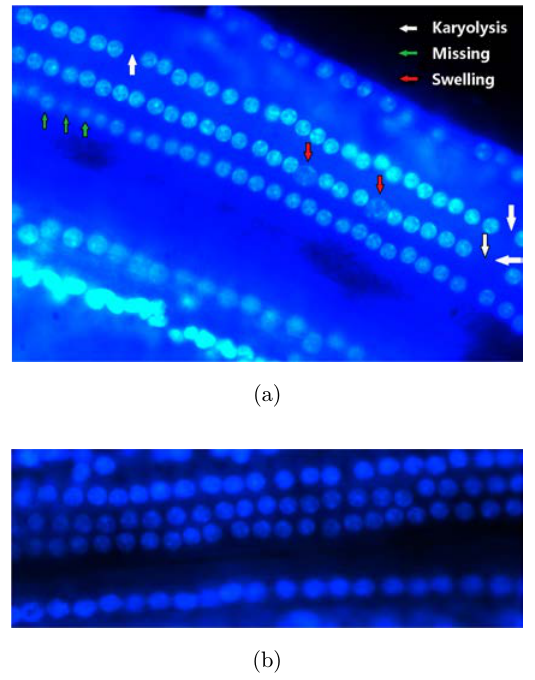
Fig. 4. The cochlear stretched preparations observed under a °uorescence microscope. The three bright bead chains in the upper left corner are the outer hair cells. (a) A cochlear speci- men of a chronically deafened guinea pig. White arrows point to the position of nucleus missing, green arrows point to the kar- yolysis and red arrows point to the swelling nucleuses and (b) A cochlear specimen of an acutely deafened guinea pig. Outer hair cells were almost intact.